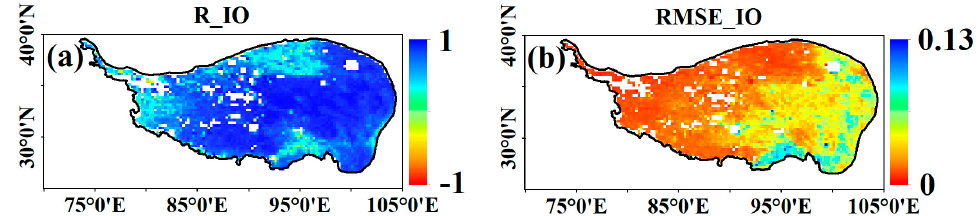
Figure 6. Difference between FY_Imp and FY_Ori SM: ( a , b ) are correlation coefficient (R_IO) and RMSE_IO between FY_Imp and FY_Ori soil moisture, respectively. The unit of RMSE_IO is cm 3 cm -3 .